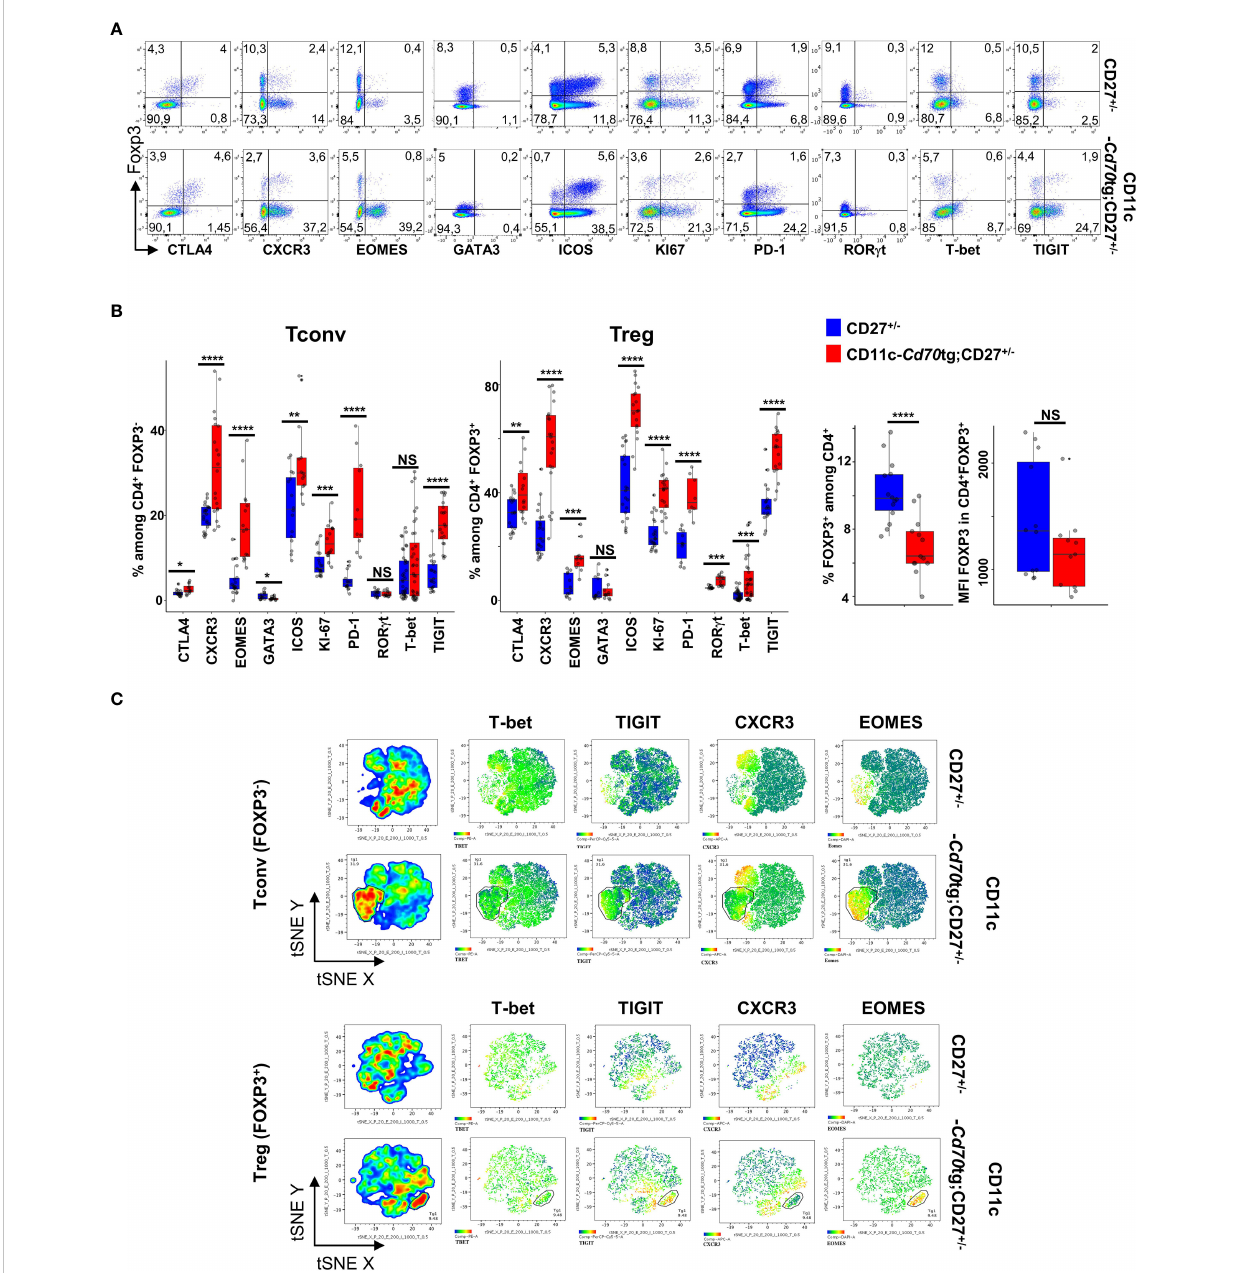
FIGURE 1 Activation of Tregs and Tconvs in CD70 transgenic mice. Spleen cells from CD27 +/- mice expressing or not a CD70 tg were harvested at 6-8 wk of age and stained ex vivo for indicated proteins. (A) Spleen cells were stained for CD4, Foxp3 and the indicated markers. Singlets were selected by gating events in the diagonal of FSC-H vs FSC-A plots. Representative fl ow cytometry plots of indicated marker on gated viable CD4 + cells. (B) Proportion of positive cells among viable CD4 + Tregs and Tconvs (left panels; proportion of Tregs and intensity of Foxp3 expression (right panels). Data are from 3-4 independent experiments with 5-8 mice per group. Bars represent median ± SD. Unpaired t-test was used to determine statistical differences followed by FDR correction for multiple comparisons (*p < 0.05; **p < 0.01; ***p < 0.001; ****p < 0.0001; ns, not signi fi cant. (C) Representative merged (n =8) t-distributed stochastic neighbor embedding (t-SNE) plot after dimensionality reduction and unsupervised clustering of fl ow cytometry data from CD4 + Tregs and